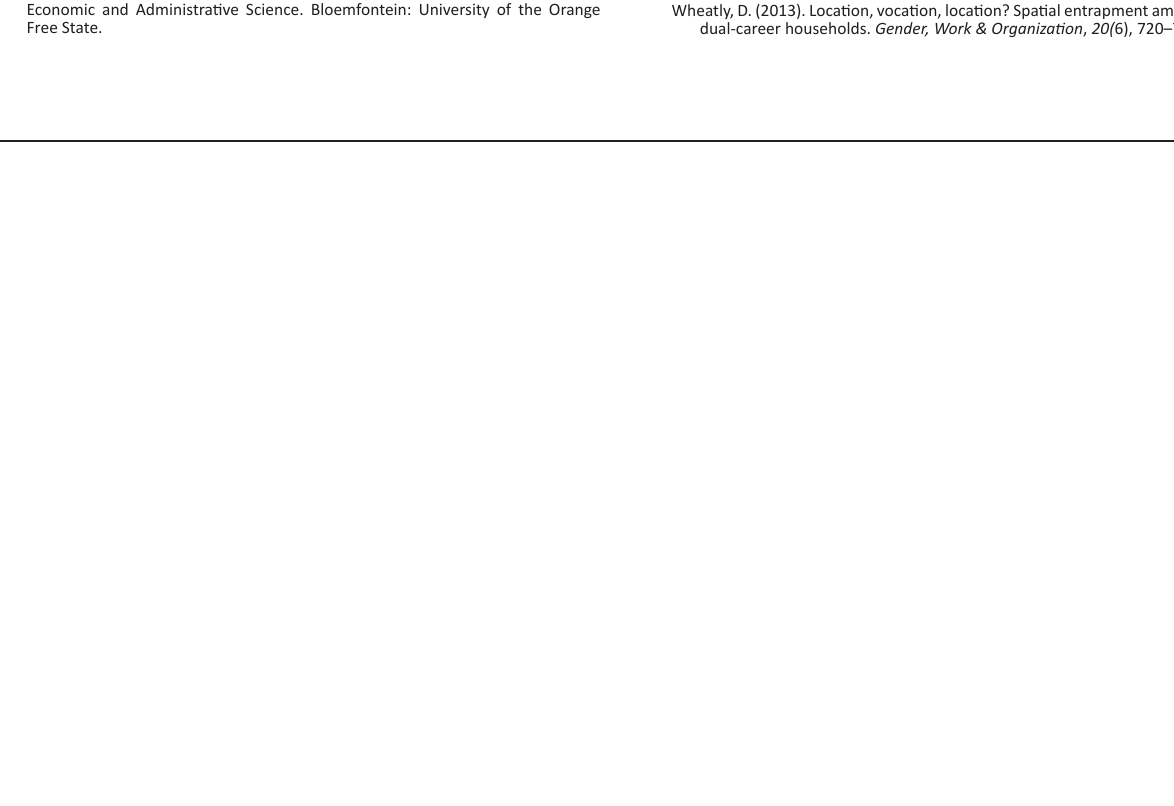
whitepaper Statistics South Africa (Stat SA). (2015). Quarterly Labour Force Survey – Quarter3 . Statistics South Africa. Retrieved September 17, 2015, from http://www.statssa.